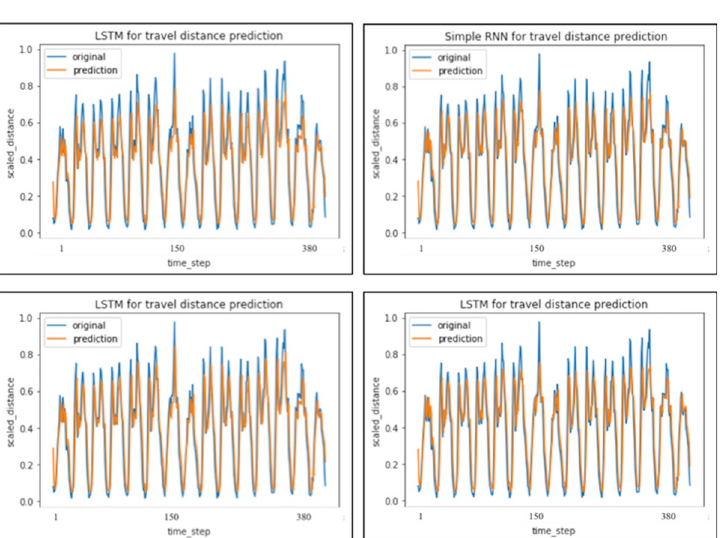
Fig 10. Top-left (LSTM with “relu” activation, 3 layers and 50 hidden nodes). Top-right (Simple RNN). Bottom-left (LSTM with “relu” activation, 3 layers and 30 hidden nodes). Bottom-right (LSTM with “tanh” activation, 3 layers with 50 hidden